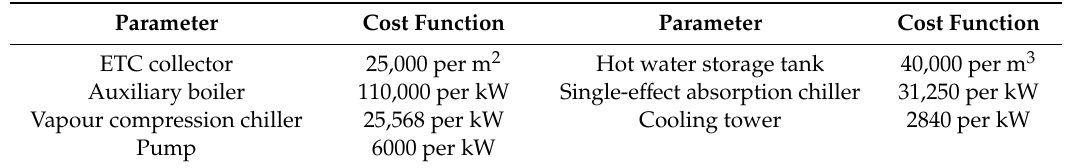
Table 4. Capital cost functions of main components obtained from market analysis (Pakistani Rupees)